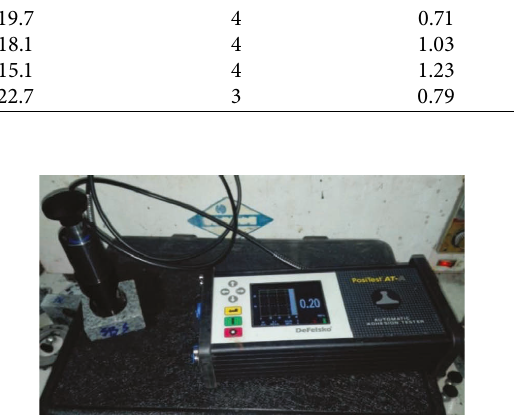
Figure 2: Automatic bond strength tester of PosiTest AT-A. Table 5: Technical parameters of PosiTest AT-A.